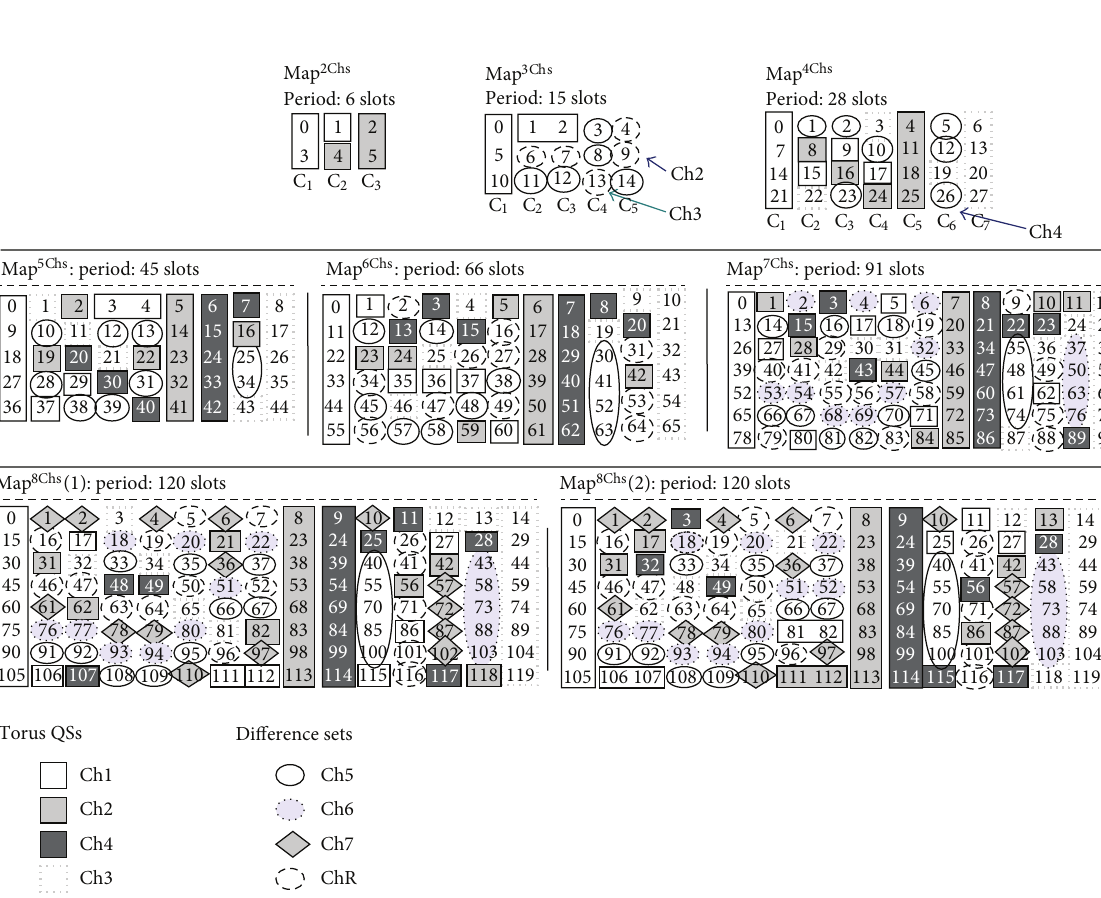
Figure 5: MtQS-DSrdv construction exemplary maps (Map 𝑟 Chs ) for 𝑟 = 2⋅ ⋅⋅ 8 channels (Chs); Chr for 𝑖 = 1 ⋅⋅ ⋅𝑟 stands for a particular i map of channel 𝑖 . With three available channels, Channel 1 is selected according to the tQ forward manner, and the next two channels are : {4,6,7,9,13} and DS : {3, 8,11, 12, 14} . These DSs are exemplary, since others could also be formed from DSs (Map 3 Chs ), that is, DS Ch 2 Ch 3 found. While having four available channels, Channel 4 is selected according to the DS rule. Starting with four available channels (Map 4 Chs ) the mirror tQ is utilized, changing twice the direction ( 𝑘 𝑖 ). With five available channels (Map 5 Chs ), Channel 2 is built using a backward tQ except of one mirror